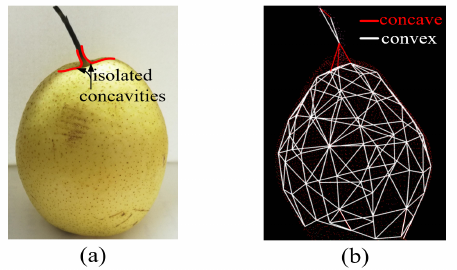
Figure 4. Judgment of the relationship between the adjacent patches of fruit stalk and pulp by concavity and convexity method. ( a ) Judgment of the boundary based on the relationship of the pear’s surface. ( b ) Concavity–convexity characteristics of each patch on the three-dimensional mesh of the pear surface.